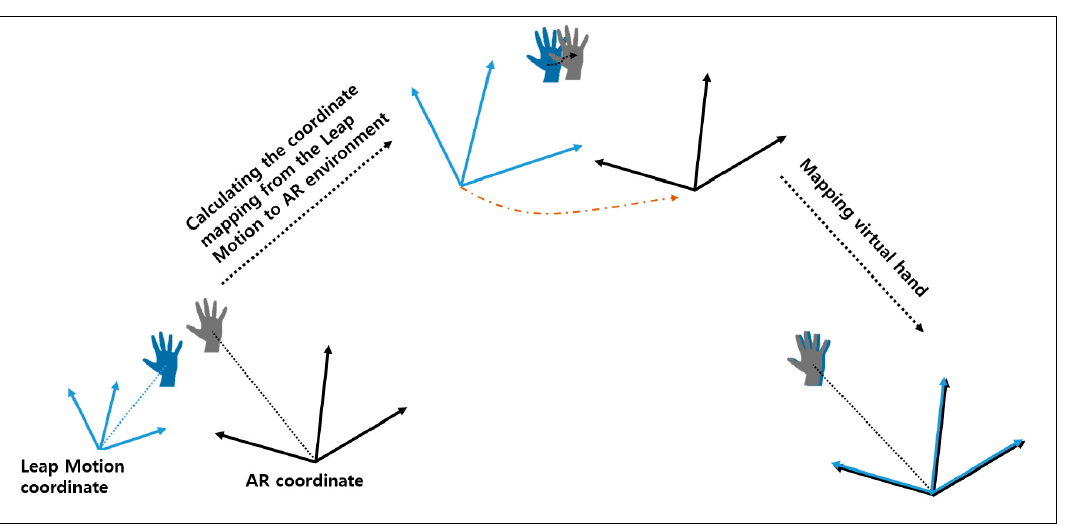
Figure 8. Difference between the wearable AR coordinate and the depth sensor coordinate.